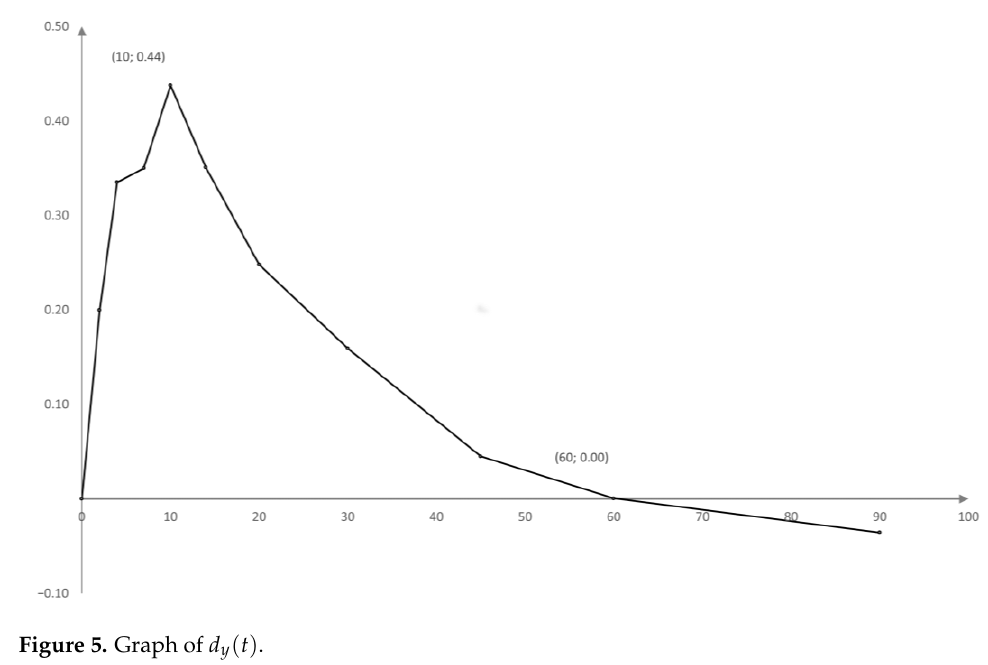
Figure 5. Graph of 𝑑 𝑦 (𝑡) . Figure 5. Graph of d y ( t ) .